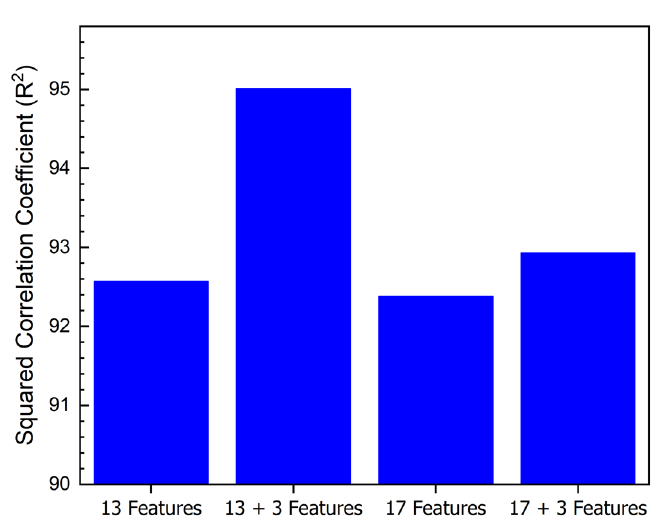
Figure 4. The predicted D max values against measured D max for the model with ( a ) 13 selected features, ( b ) 13 selected features and added characteristic temperatures, ( c ) 17 selected features, and ( d ) 17 selected features and added characteristic temperatures.